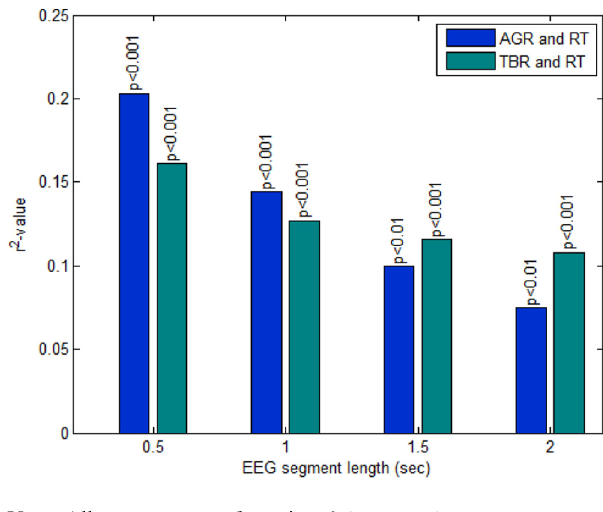
Figure 3. Correlation coef fi cient between AGR and RT (blue) and TBR and RT (green) for different EEG segment